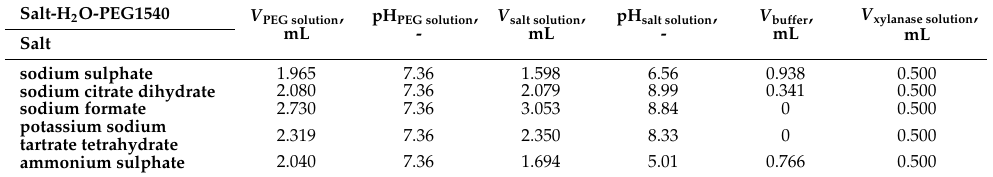
Table 1. ATPS component